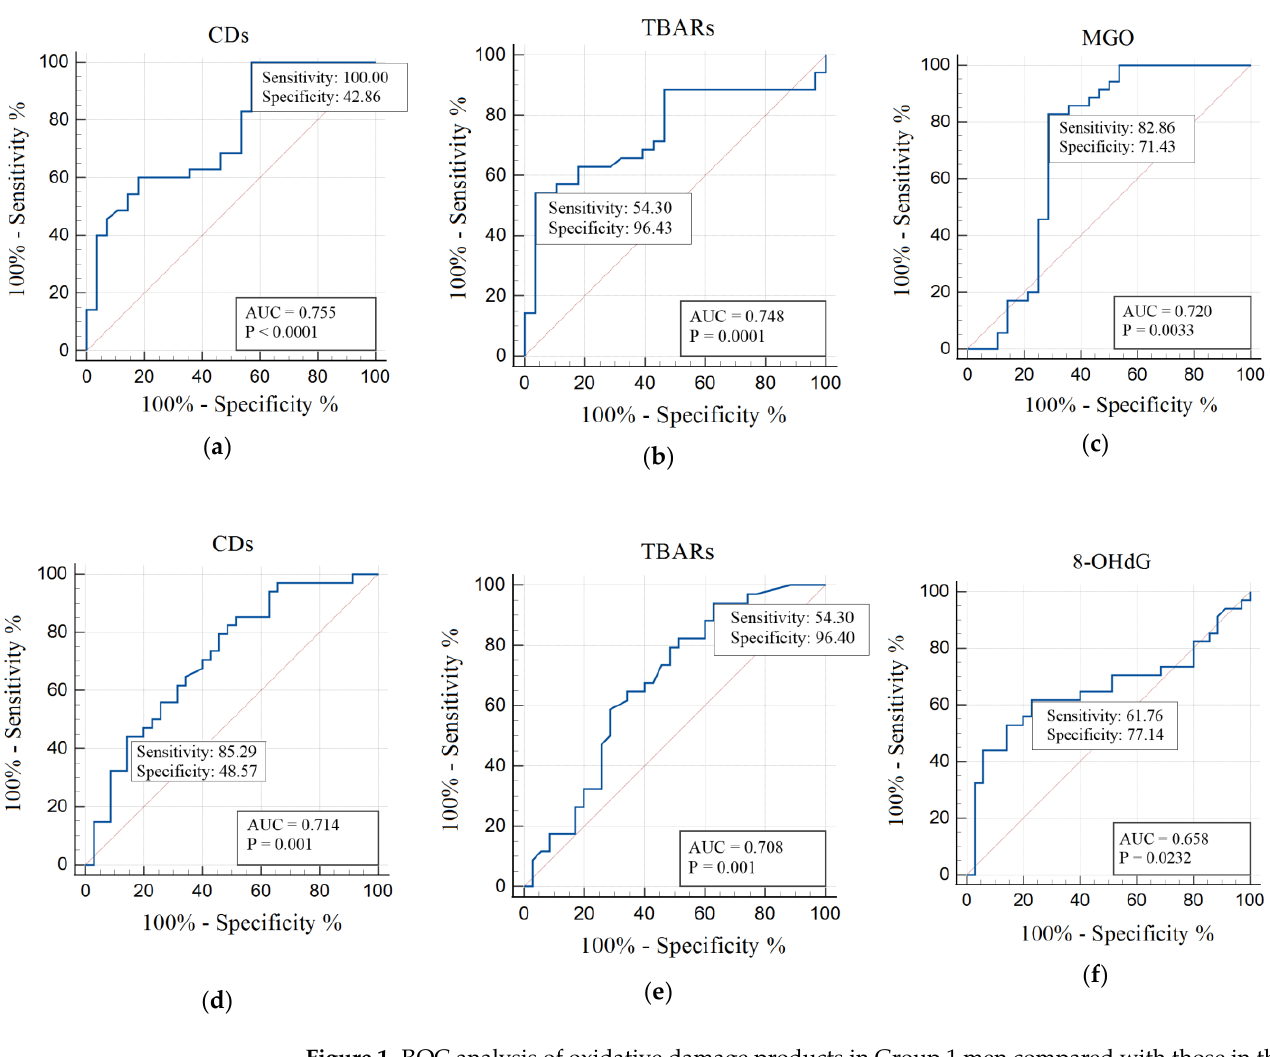
Figure 1. ROC analysis of oxidative damage products in Group 1 men compared with those in the control group ( a – c ) and in Group 2 men in comparison with Group 1 ( d – f ). Abbreviations: AUC, area under curve; CD, conjugated dienes; TBARs, thiobarbituric acids reactants; MGO, methylglyoxal; 8-OHdG, 8-hydroxy-2-deoxyguanosine; p , statistically significant differences.